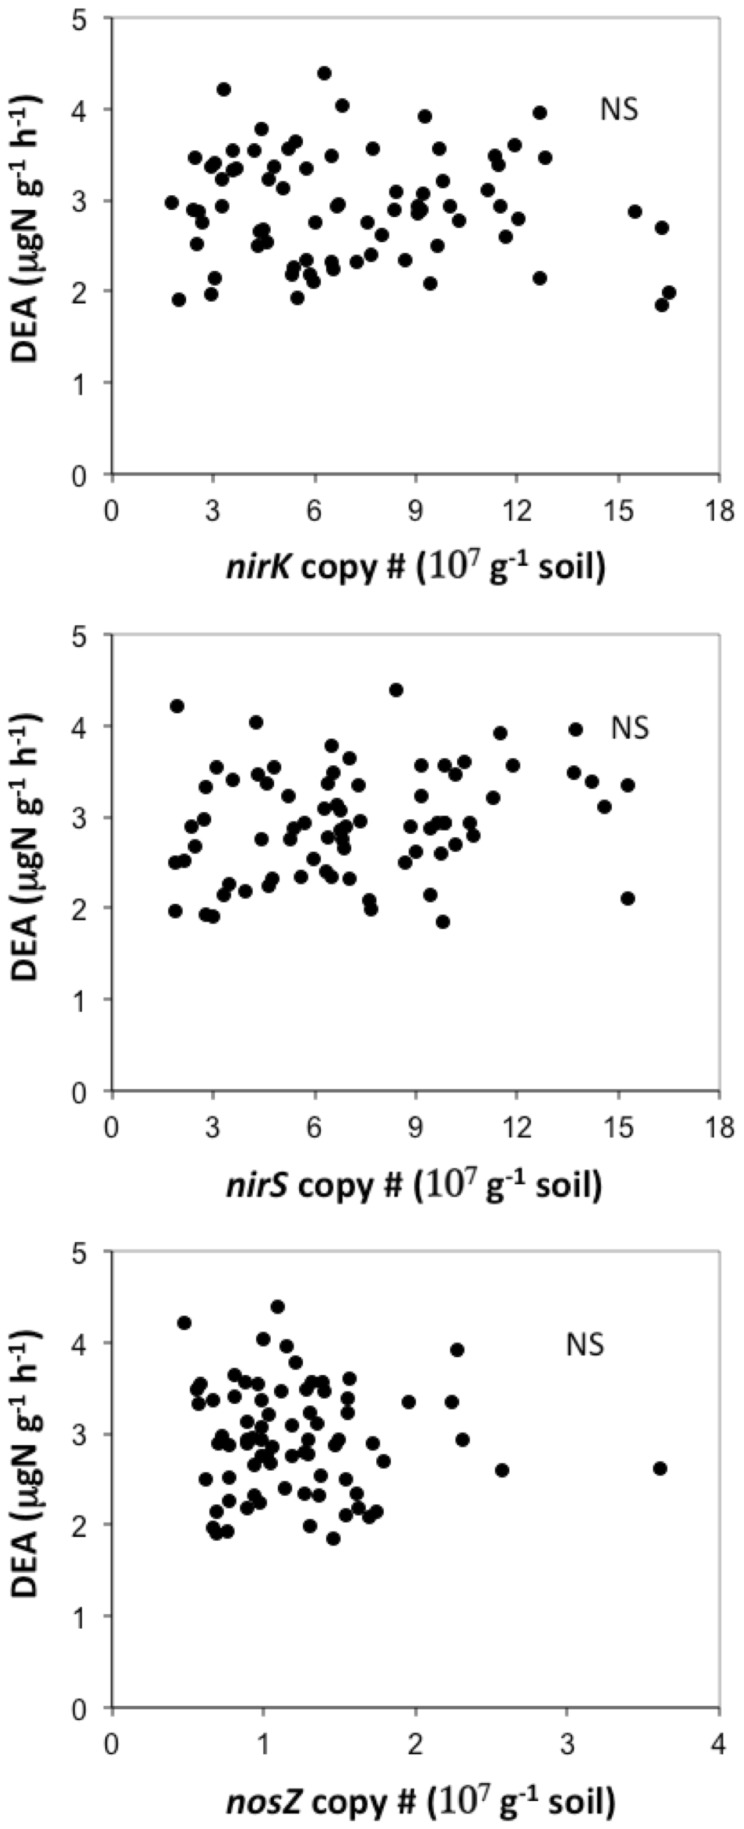
Relationship Between Plant Diversity-induced Changes In Denitrifier Abundance And Denitrifying Enzyme Activity.Correlations between DEA and the abundance of (top) nirS–harbouring denitrifiers, (middle) nirK–harbouring denitrifiers and (bottom) nosZ–harbouring denitrifiers in soil, in 2006. No significant correlation was observed (all p>0.05).